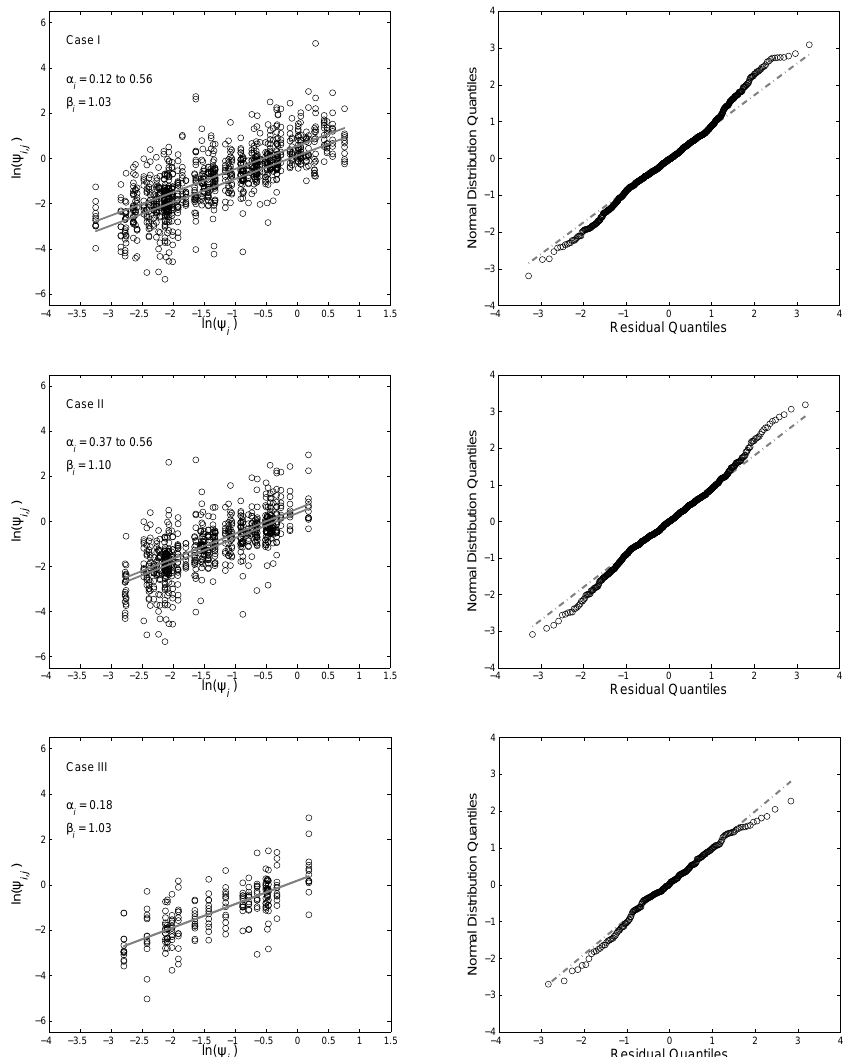
Fig. 7. Left: Plot of ln( ψ i,j ) versus ln( ψ i ) for Cases I to III using only those events that passed the Lilliefors test. To plot the lines, we used values of α i (intercept) and β i = β (slope) obtained from our statistical analysis, but assumed γ i ln( a ′ j )=0 . The bottom line in a plot represents the minimum value of α i among events while the top line represents the maximum value of α i . Right: QQ plot of residuals obtained from statistical analysis results. See Figure 6 for comparison.